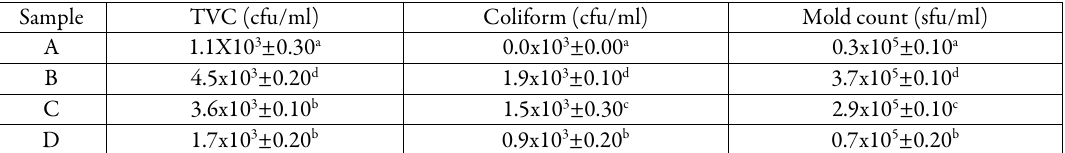
Table 2. Microbial count of bread